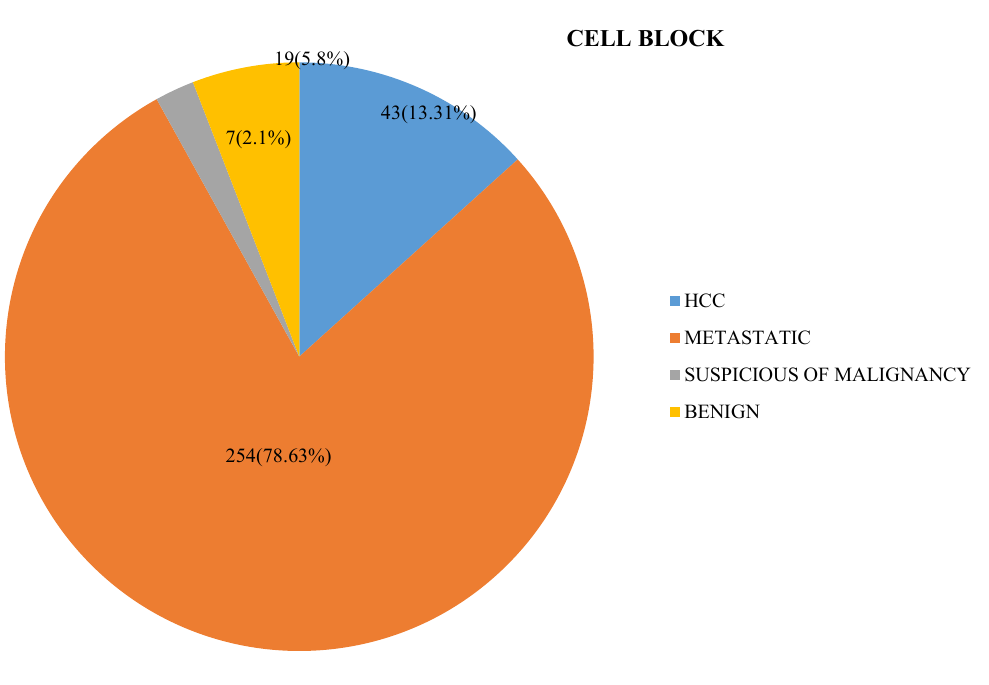
Fig. 3. Distribution of the cases in cell block preparation